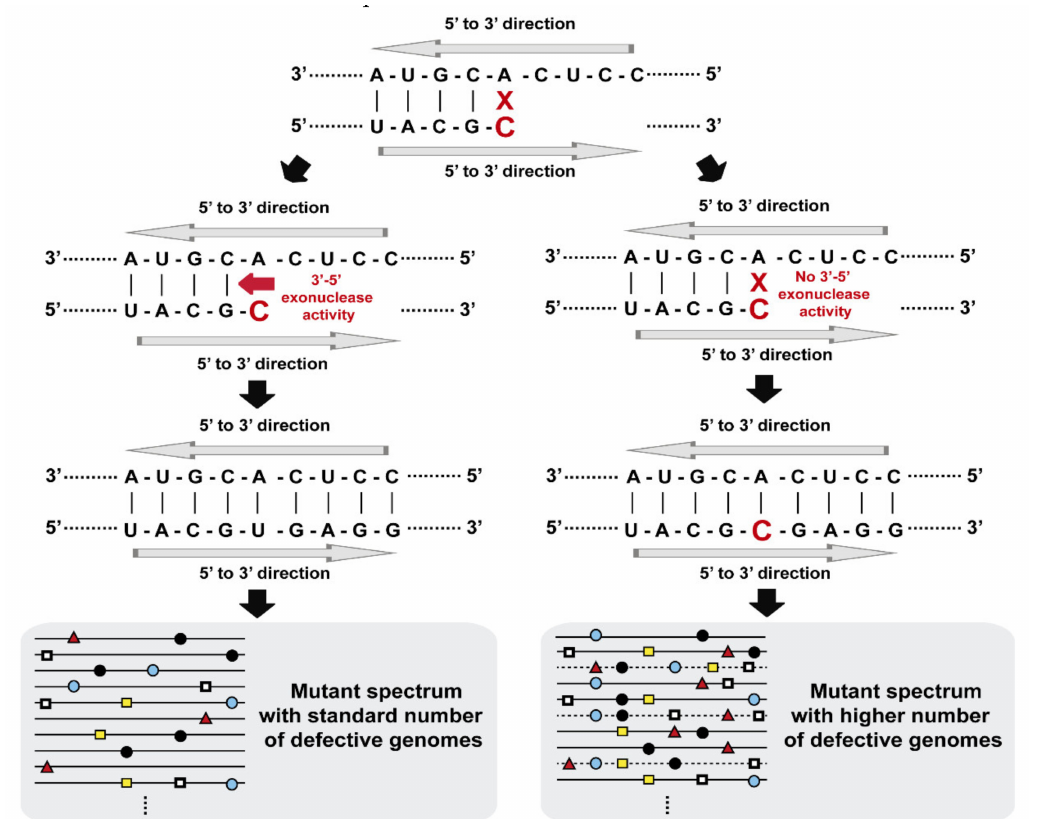
Figure 2. Scheme that illustrates mutant spectrum complexities in the absence and presence of a 3 (cid:48) -5 (cid:48) exonuclease activity during viral replication. Residue A (on the top) can be misread to incorporate a C in the complementary strand. In the presence of a proofreading activity, the mutant spectrum (represented by lines with mutations as colored symbols) contains a standard number of defective genomes (depicted on the left). In the absence of a proofreading activity, there is an accumulation of mutations per genome that can eliminate viral replication (indicated by discontinuous lines of mutant spectrum on the